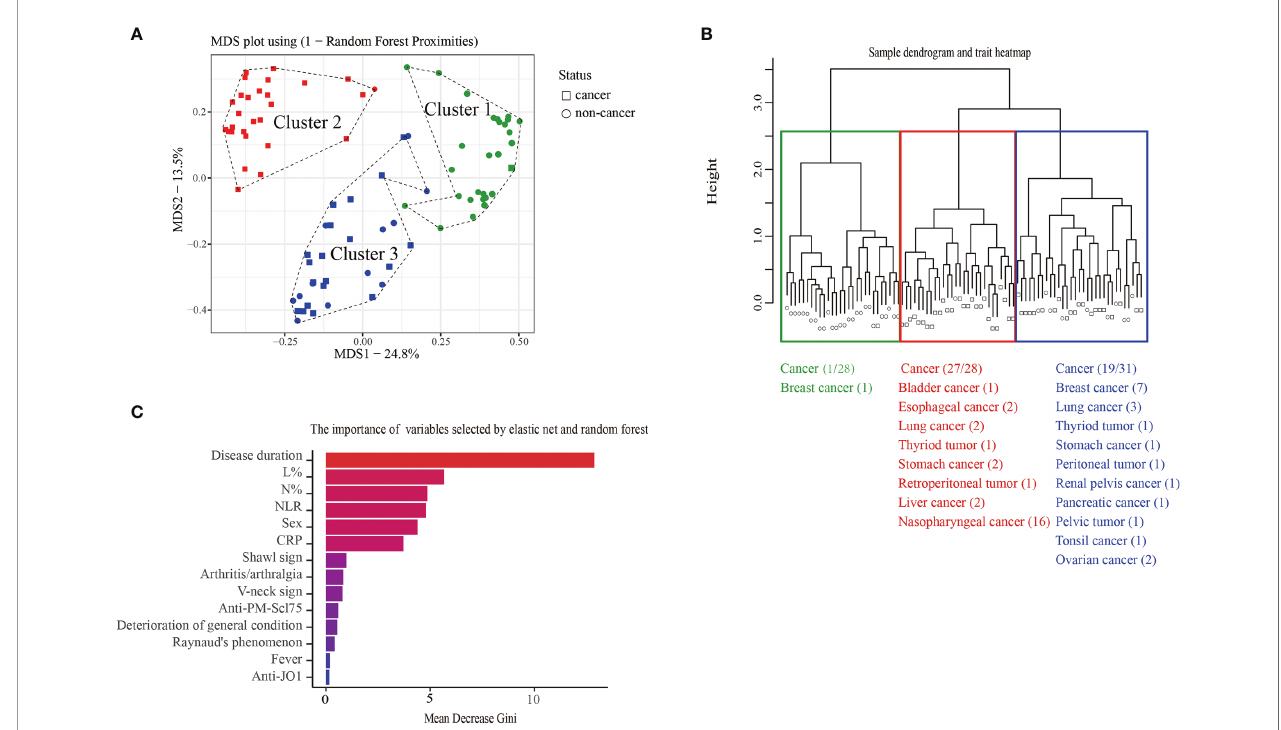
FIGURE 2 | (A) The MDS plot and (B) hierarchical cluster analysis of 87 anti-TIF1 g + myositis patients based on random forest proximities that were calculated by 14 clinical variables showed three distinct clusters and the distribution of cancer in each cluster. (C) The bar plot represents the importance of clinical variables evaluated by random